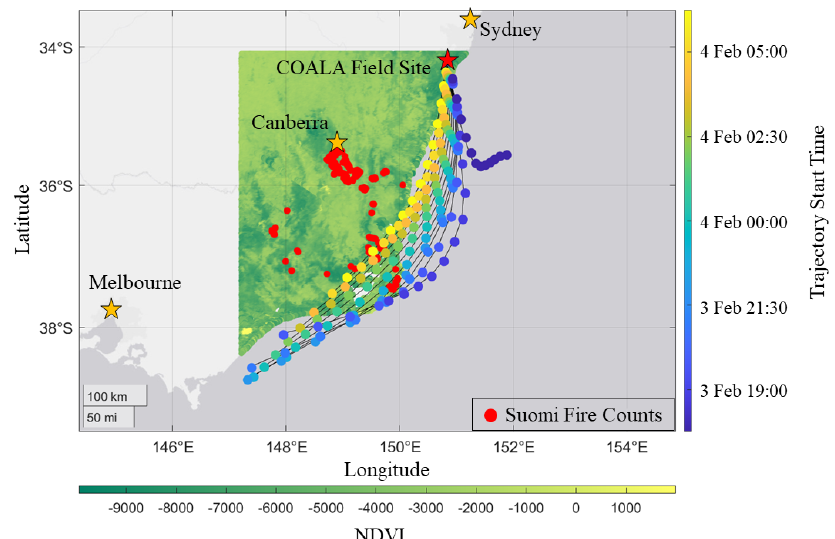
Figure 1. Active fires from 1–5 February 2020 and their proximity to the COALA-2020 field site. Normalized Difference Vegetative Index (NDVI) is plotted at 250m resolution from the MOD13A1 dataset acquired by measurements via the MODIS Terra satellite. Pixels have been filtered to contain cloud coverage less than 30% and VI usefulness bits indicating top two tiers of data quality. Fire counts are plotted using the VNP14IMGTDL_NRT data from Suomi VIIRS satellite imaging overlaid with HYSPLIT back trajectories. Each tail represents a trajectory 12h prior to reaching the site and is colored by its starting time. Circles indicate 1h intervals moving backwards from the start time.